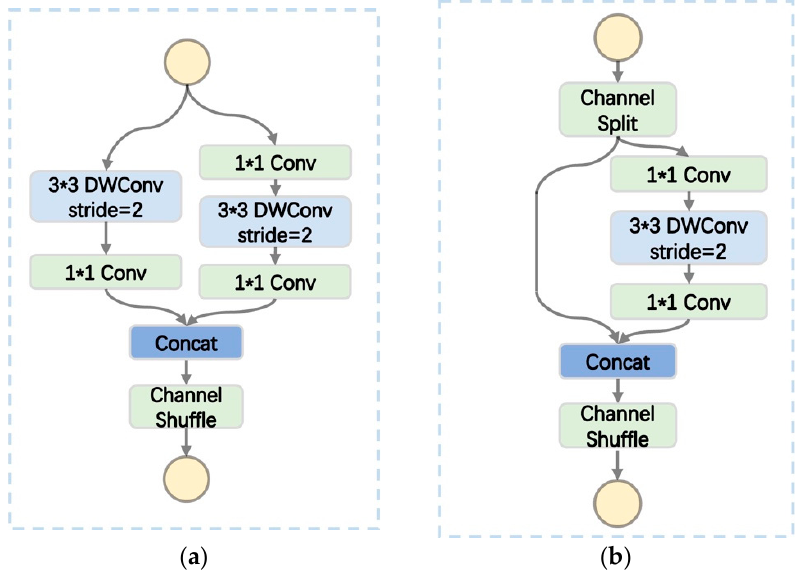
Figure 10. ( a ) Inverted Residual_1; ( b ) Inverted